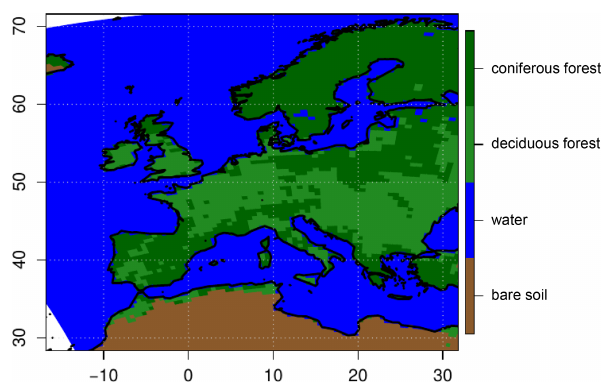
Figure 1. Spatial distribution of the land use classes used in the FOREST